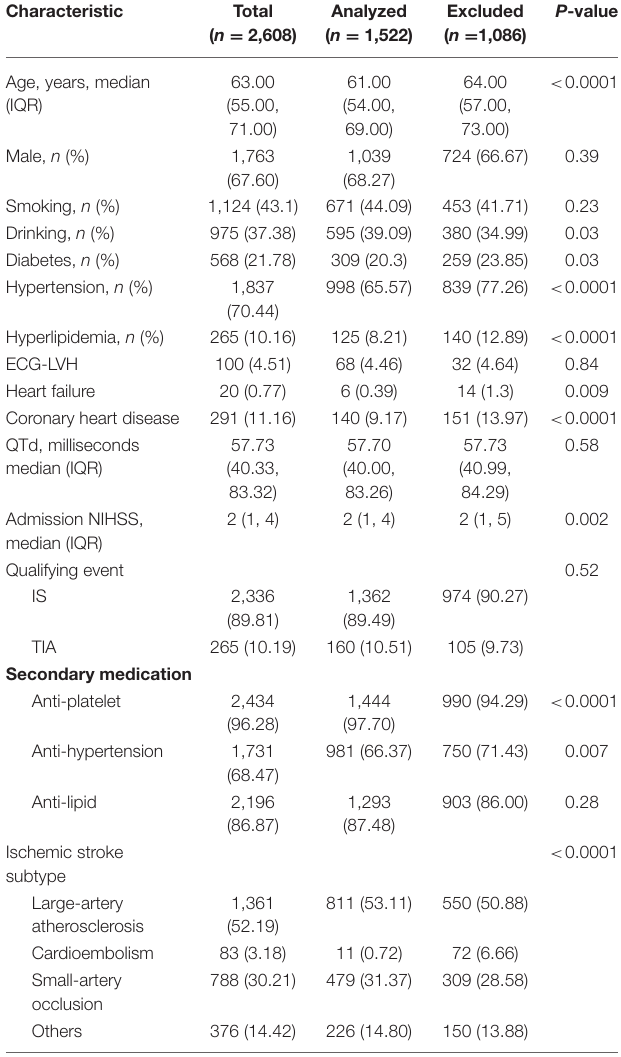
TABLE 1 | Baseline characteristics of patients included vs.